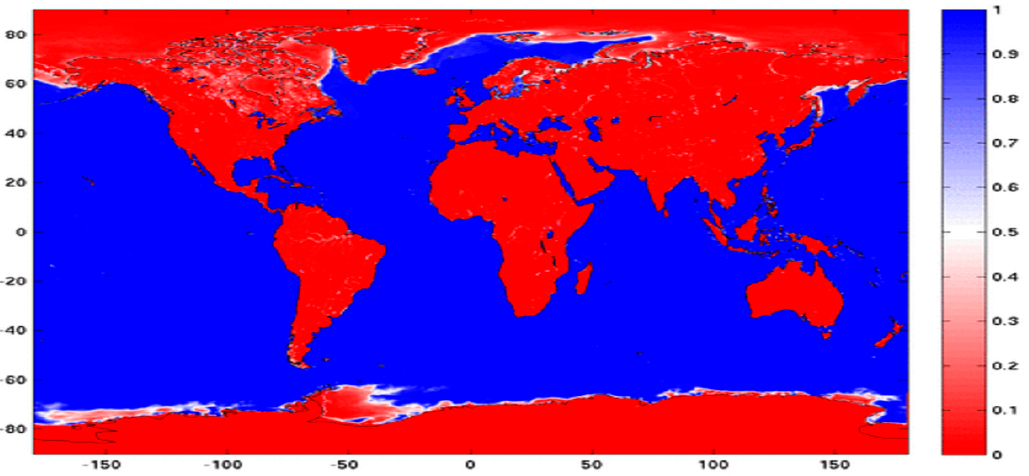
Figure 11. Mask showing the extensions of land / ice pixels versus ocean pixels, as derived from January 2010 SMOS BT measurements.